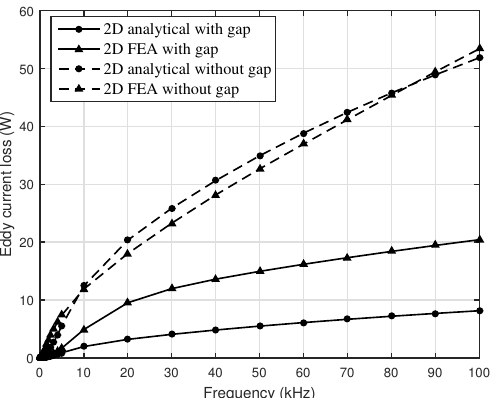
Figure 5. Comparison of loss vs. frequency between analytical and FEA